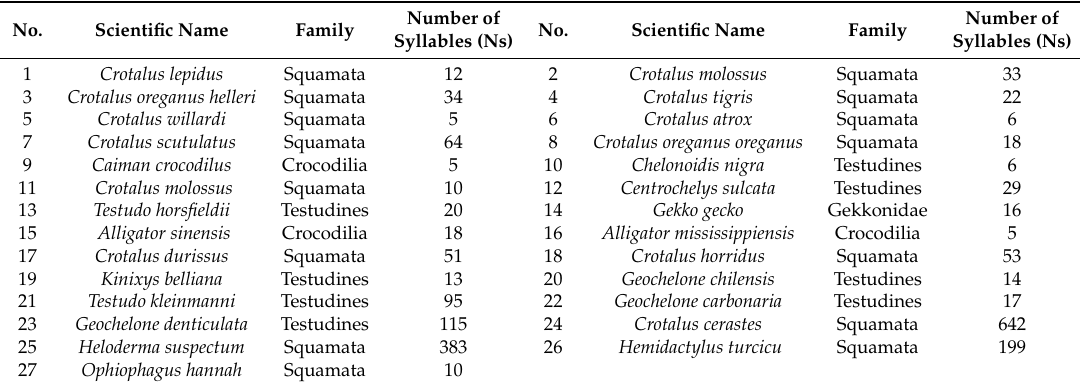
Table 1. Dataset